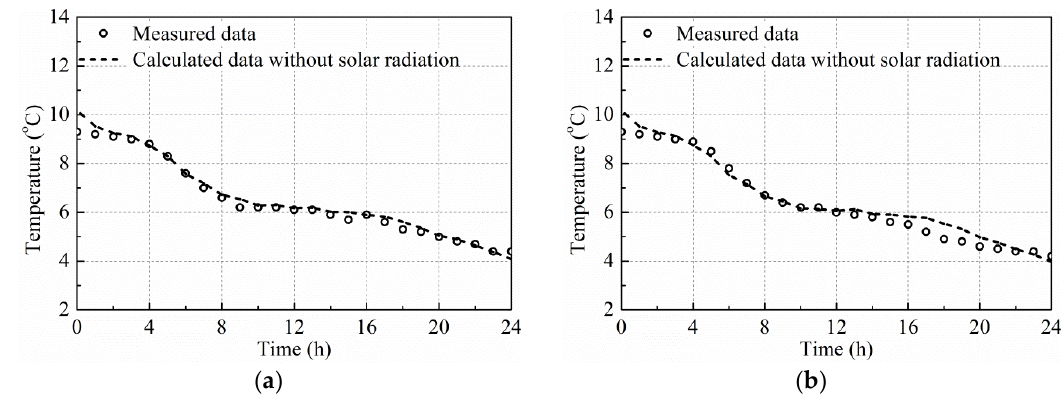
Figure 13. Influence of solar radiation on temperature distribution on cross-section of box girder in winter (16 December 2010): ( a ) east web (EW-1); and ( b ) bottom flange (B-1).